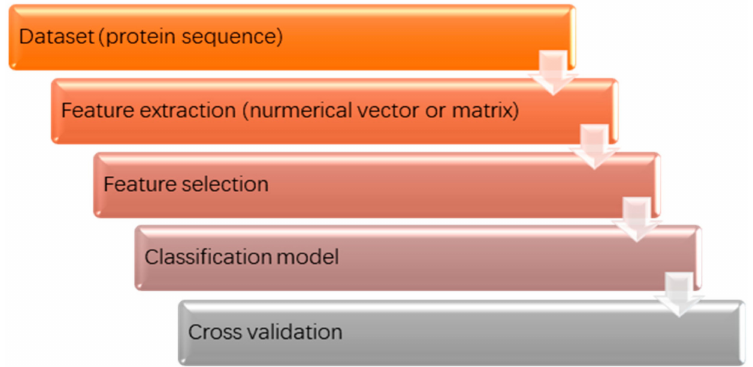
Figure 1. Schematic showing general procedure for protein structural class prediction by using machine learning (ML)